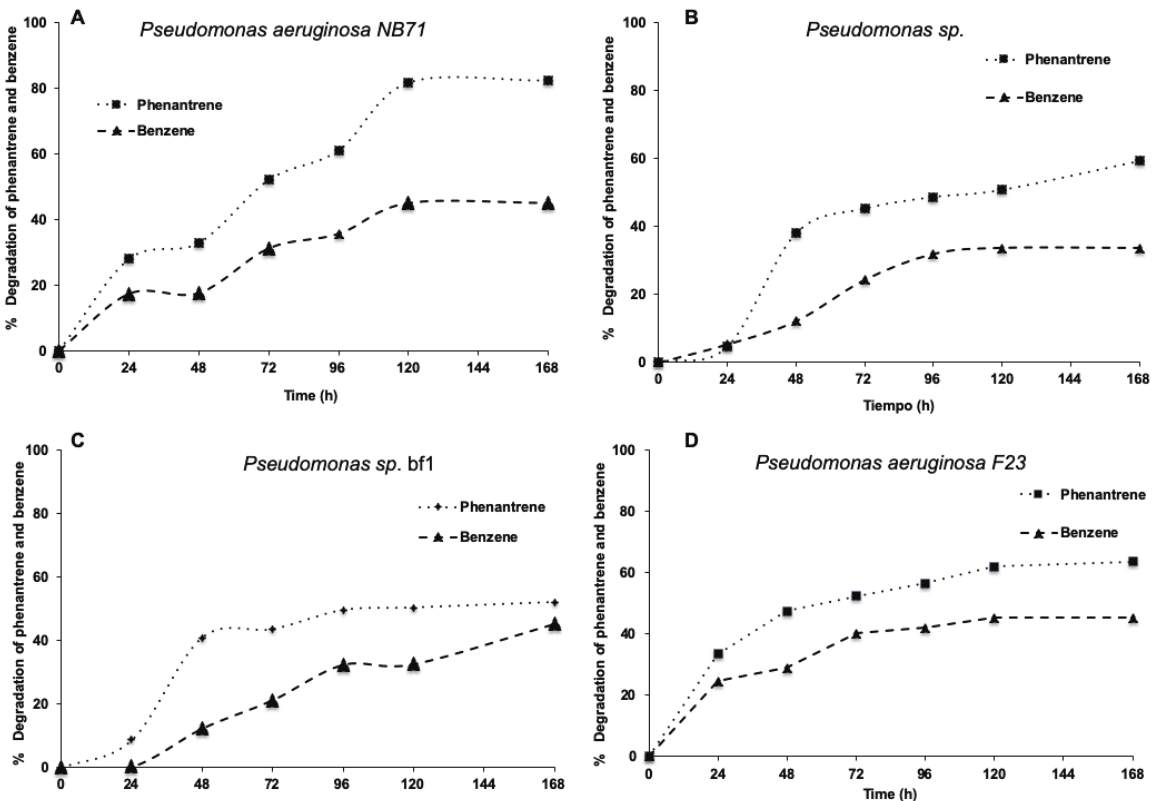
Figure 3: Percentage of biodegradation by Pseudomonas strains in 500 ppm phenanthrene and 1000 ppm benzene, quantified by